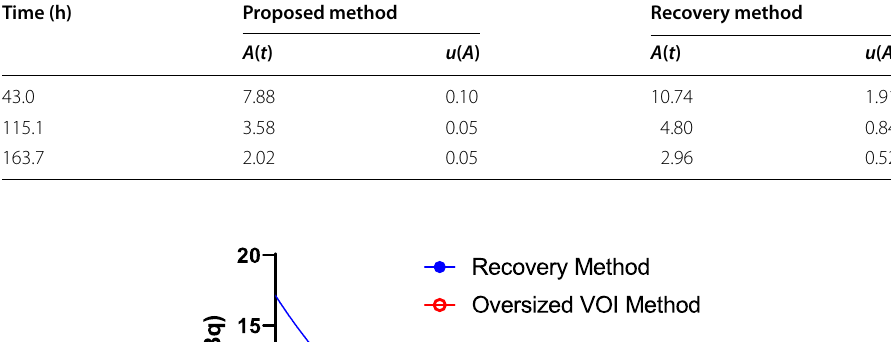
Table 3 Time, activity ( A ) and uncertainty in activity measurement u ( A ) for a bone metastases in an [ 131 I]mIBG patient who underwent 3 SPECT imaging after radionuclide therapy ×